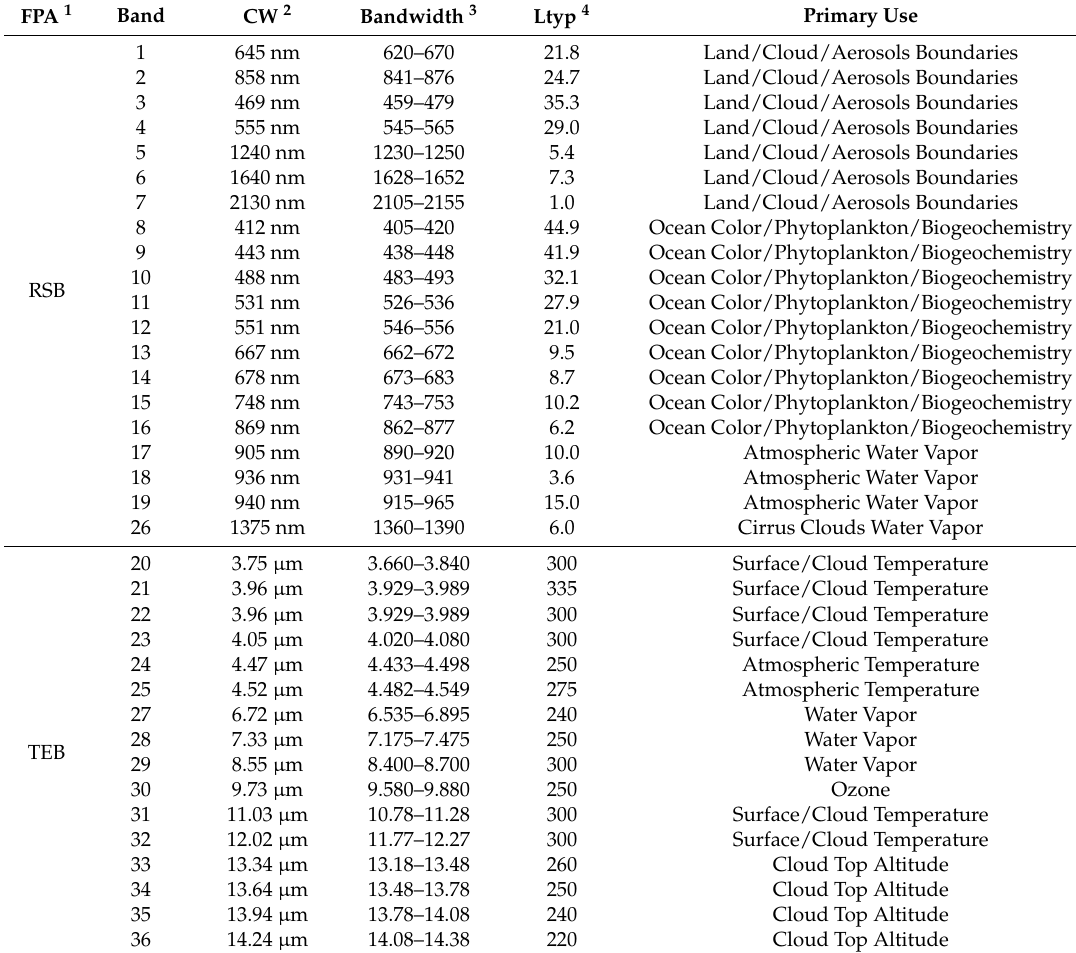
Table 1. Specifications of moderate resolution imaging spectroradiometer (MODIS) spectral